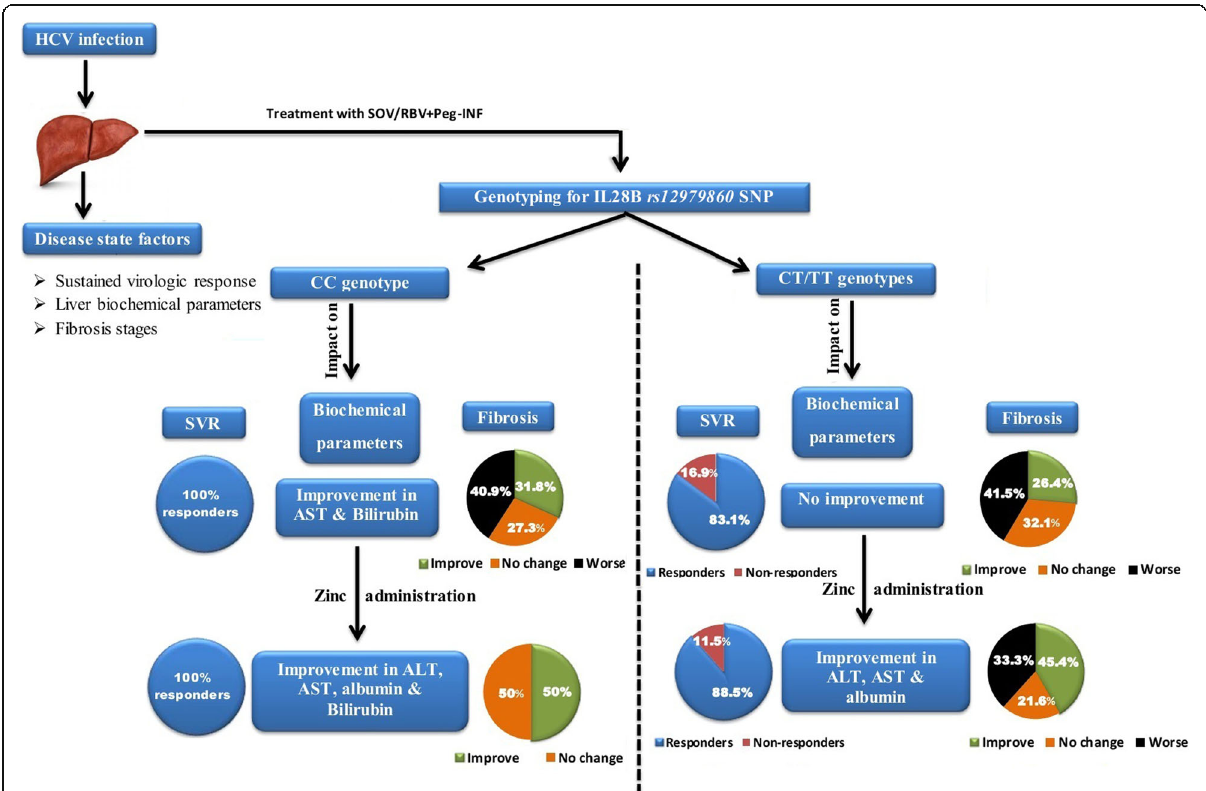
Fig. 4 Study overview and key points. In this summarized figure, antiviral triple treatment (SOV/RBV + Peg-INF) was selected due to its favorable outcome on liver damage and fibrosis compared to dual treatment. Fibrosis state was evaluated by FibroScan. SVR: Sustained virologic response. Biochemical parameters are liver function tests including alanine and aspartate aminotransferase (ALT&AST), albumin, and total